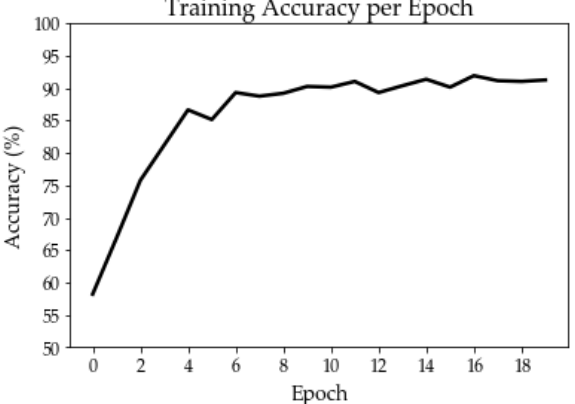
Figure 6. Classifier training for normal validation.